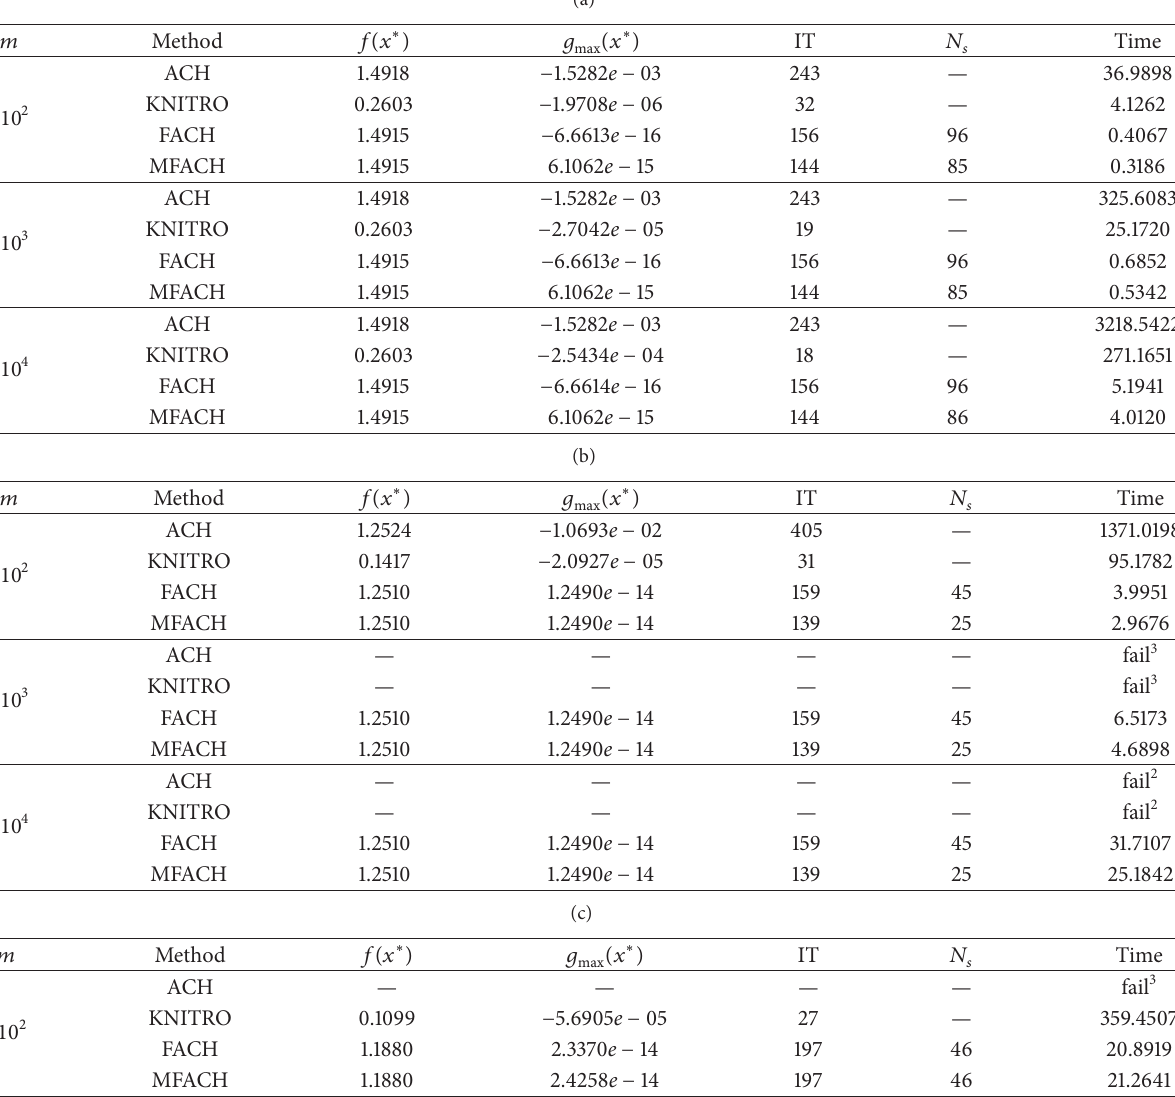
Table 3: (a) Test results for Example 17 with 𝑛 = 100 . (b) Test results for Example 17 with 𝑛 = 500 . (c) Test results for Example 17 with 𝑛 = 1000 . (d) Test results for Example 17 with 𝑛 = 2000 .